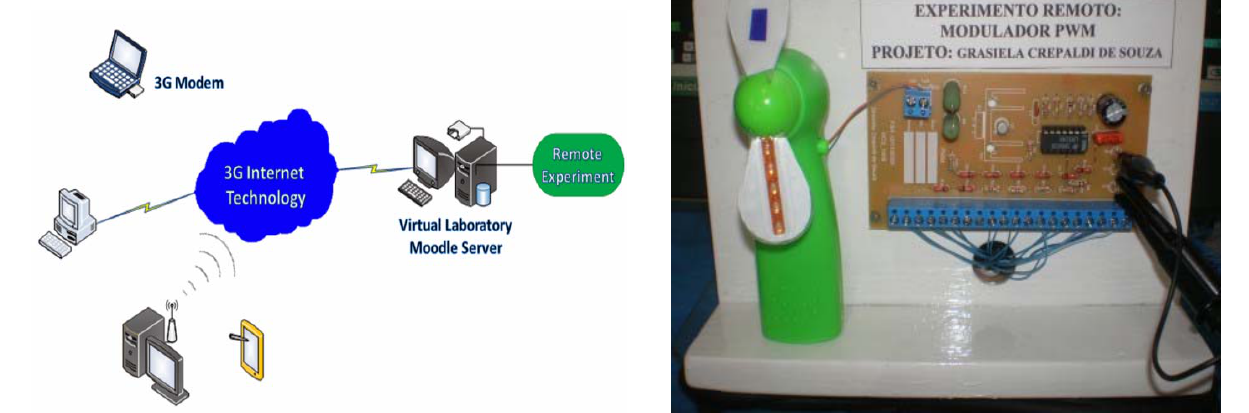
Figure 12. Link to Illustration of the distance education system